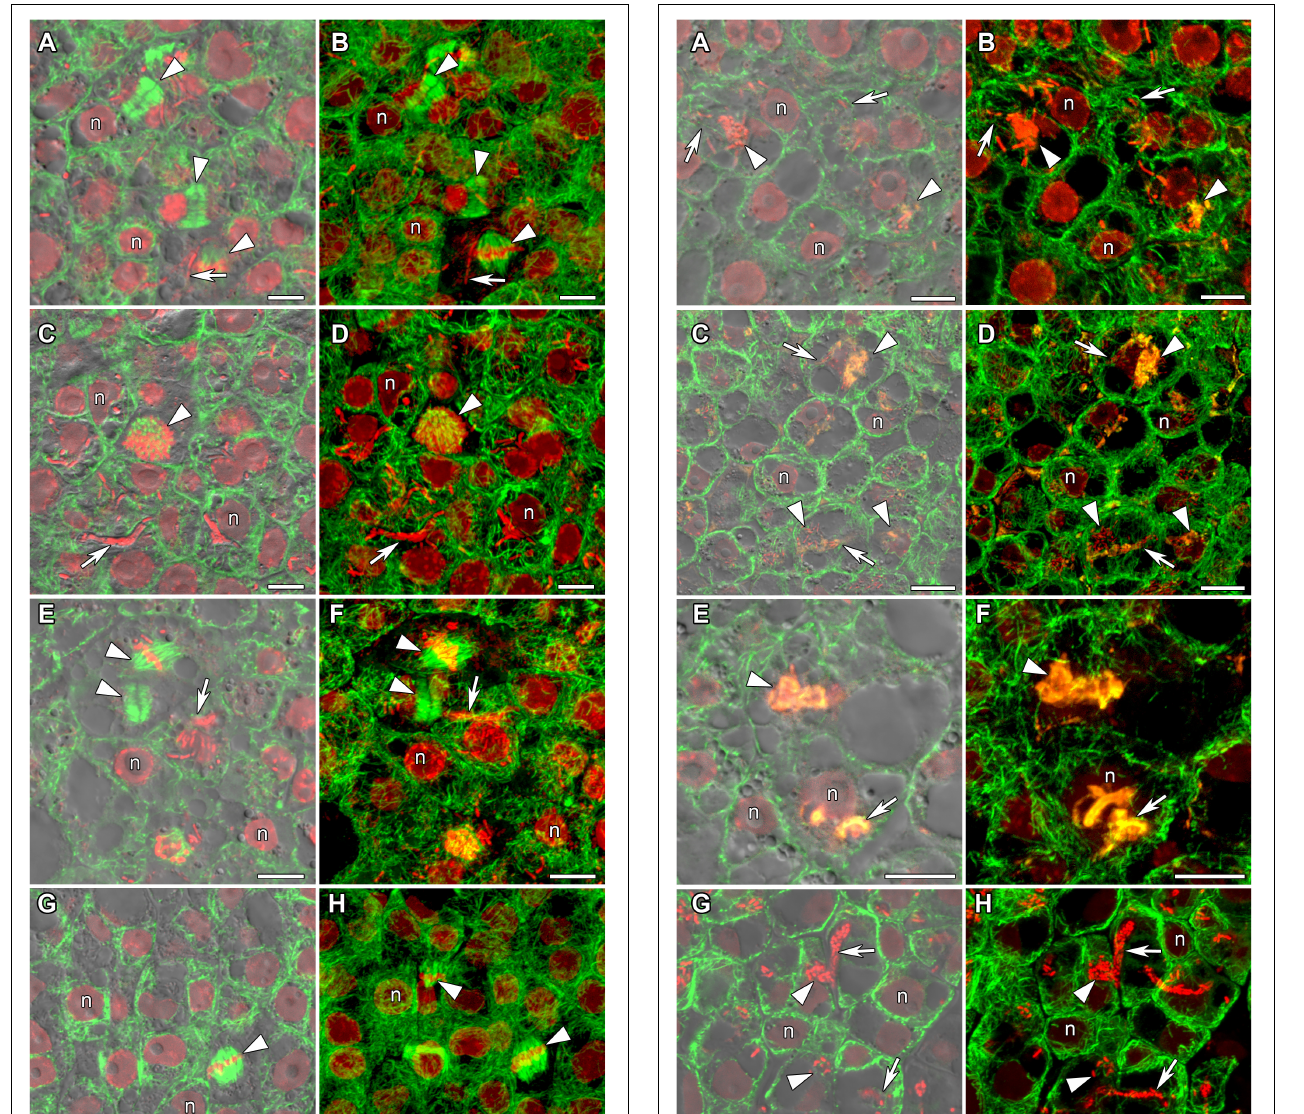
along infection threads and formed a dense network around infection